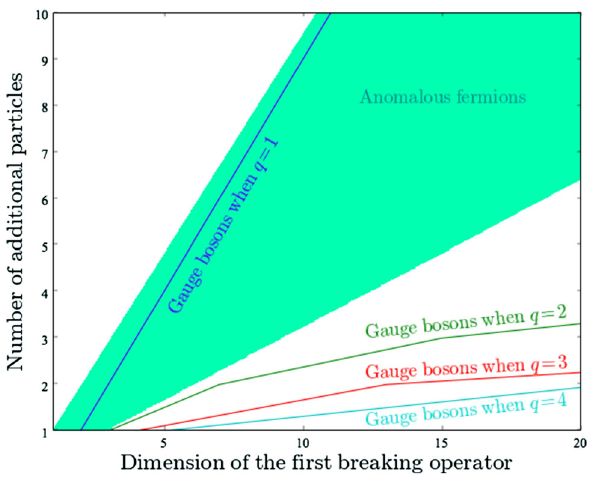
Fig. 2 Number of additional particles function of the first explicit breaking operator dimension